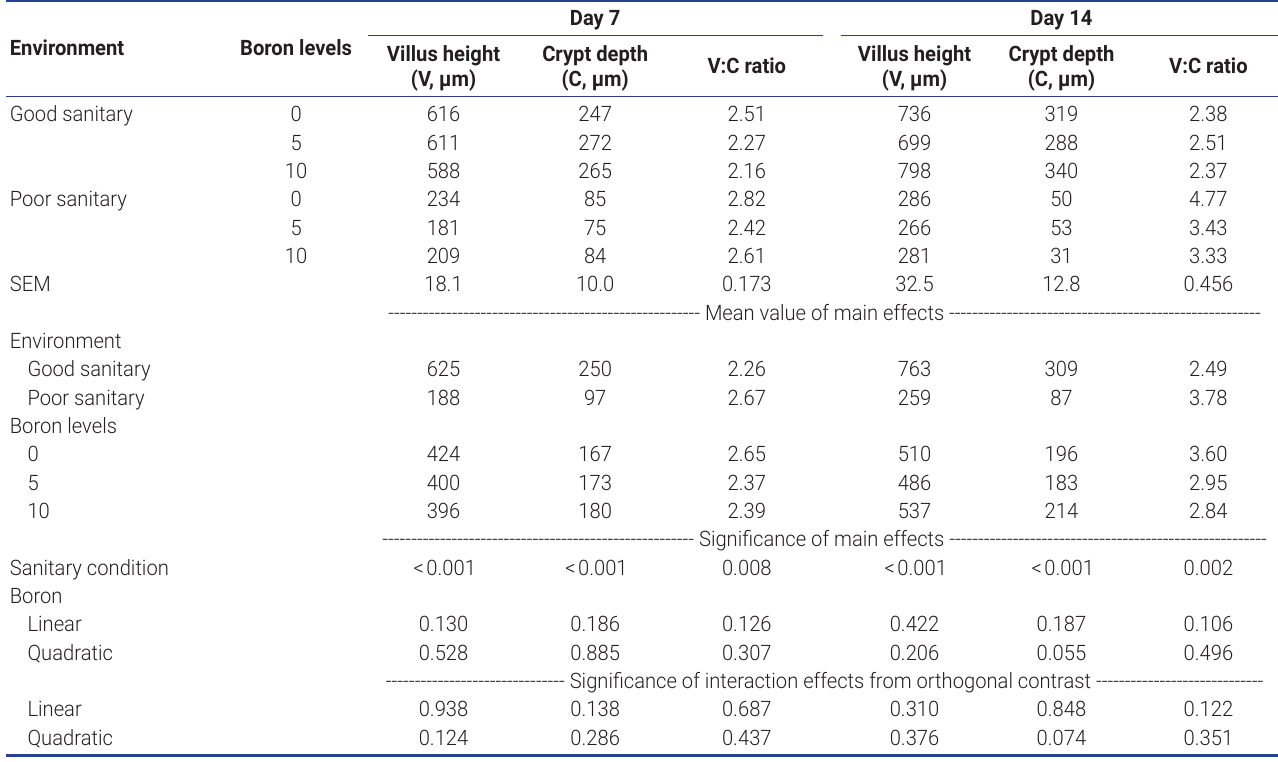
Table 3. Effects of environment and boron levels (mg/kg) on ileal morphology in weaned pigs on day 7 and 14